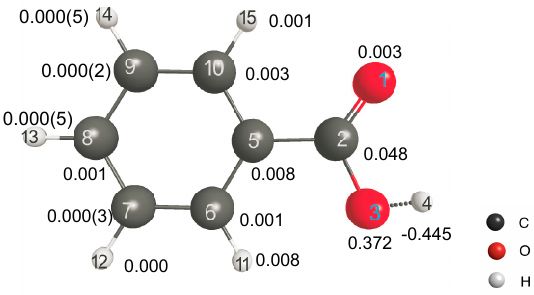
Allatoms (cid:110) (cid:111) Allatoms δ B O-H / δ v(L) { } , of the δ B O-H / δ v ( L ) , of the L Allatoms δ B O-H / δ v(L) { } L , of the L